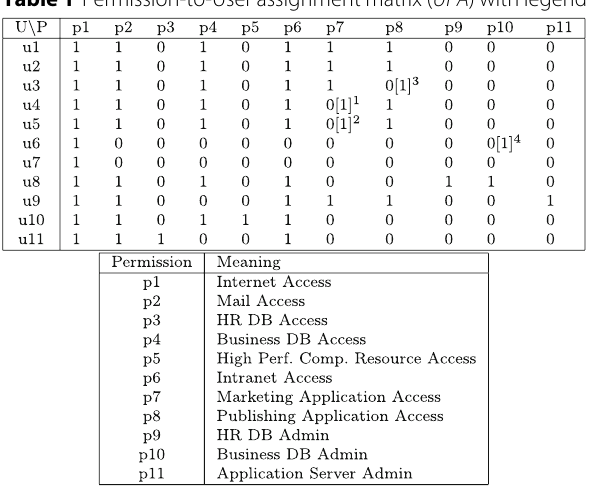
Table 1 Permission-to-User assignment matrix ( UPA ) with legend